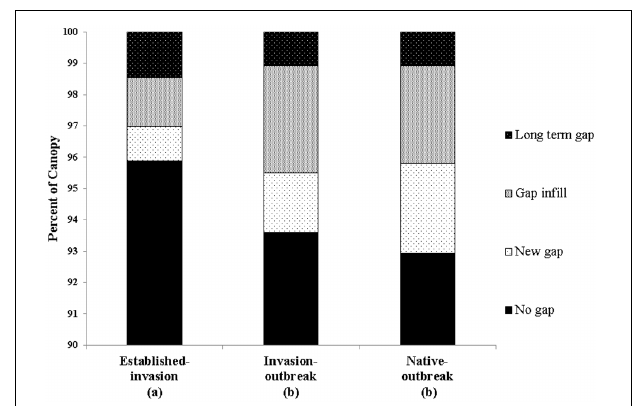
FIGURE 5 | Net change in top-of-canopy height (TCH) between 2007 and 2016. Different letters below the x -axis indicate statistically significant differences between forest types ( Table 1 ).